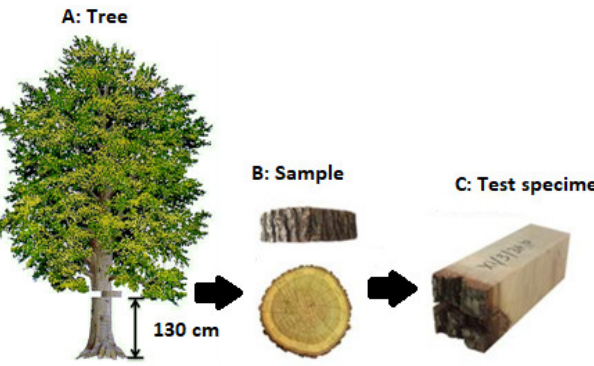
Figure 2. Sequential steps to get the samples for testing the shear strength. Ten test specimens of dimensions 30 × 30 × 50 (T × R × L) were made from each sam-